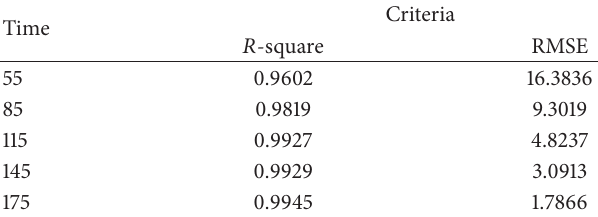
Figure 9: Thermal image of the ROI at 𝑡 = 175 sec.